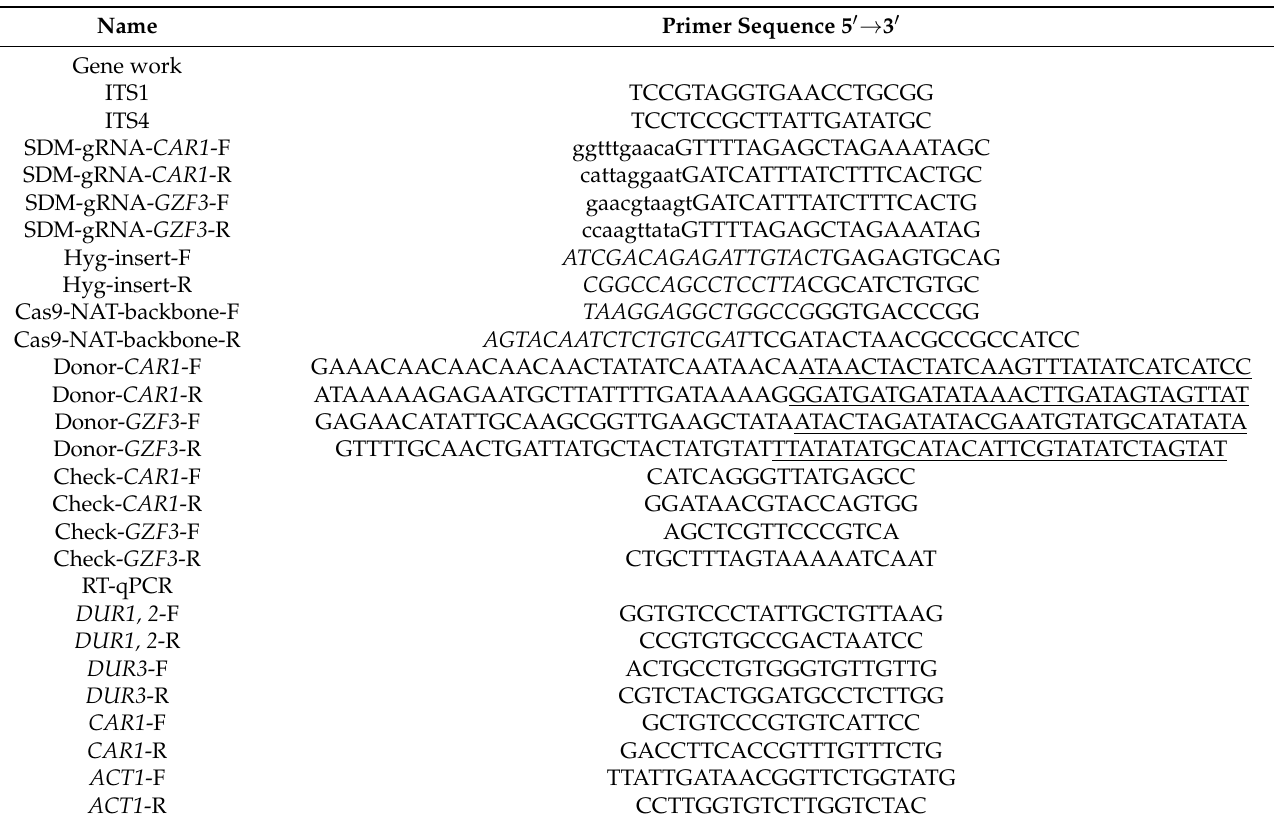
Table 2. Primers used in this